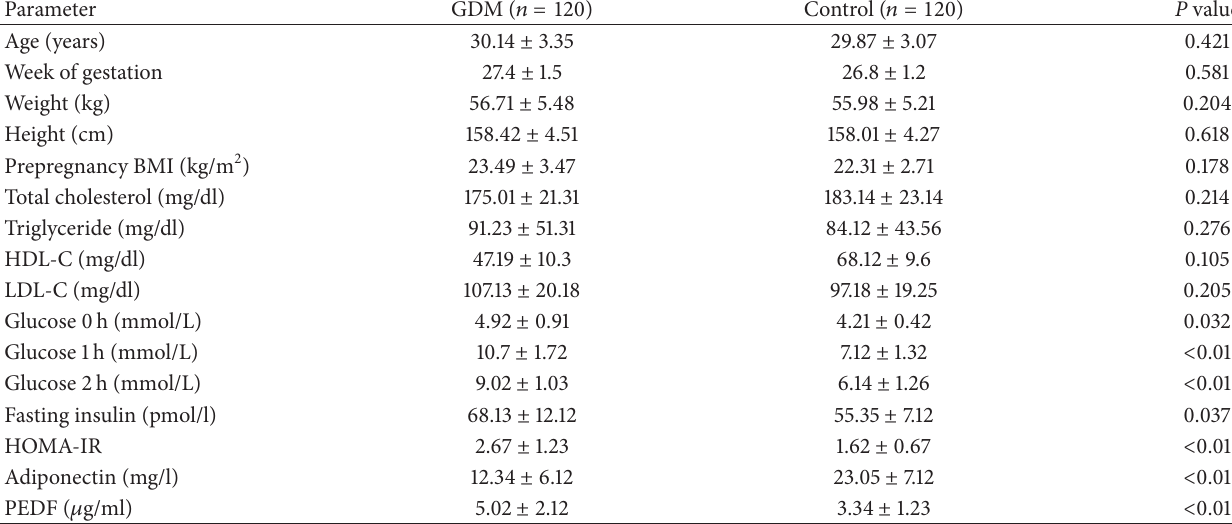
Table 1: Clinical and biochemical characteristics of gestational diabetes mellitus (GDM) patients and